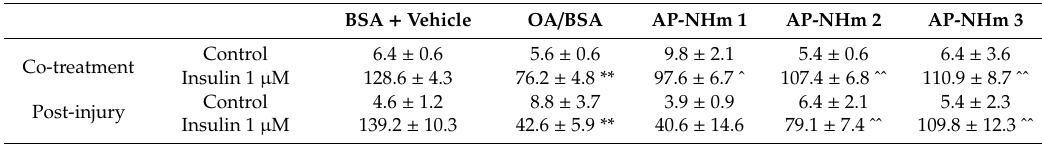
Table 3. E ff ects of OA and AP-NHm mixture on glucose uptake following stimulation with 1- µ M